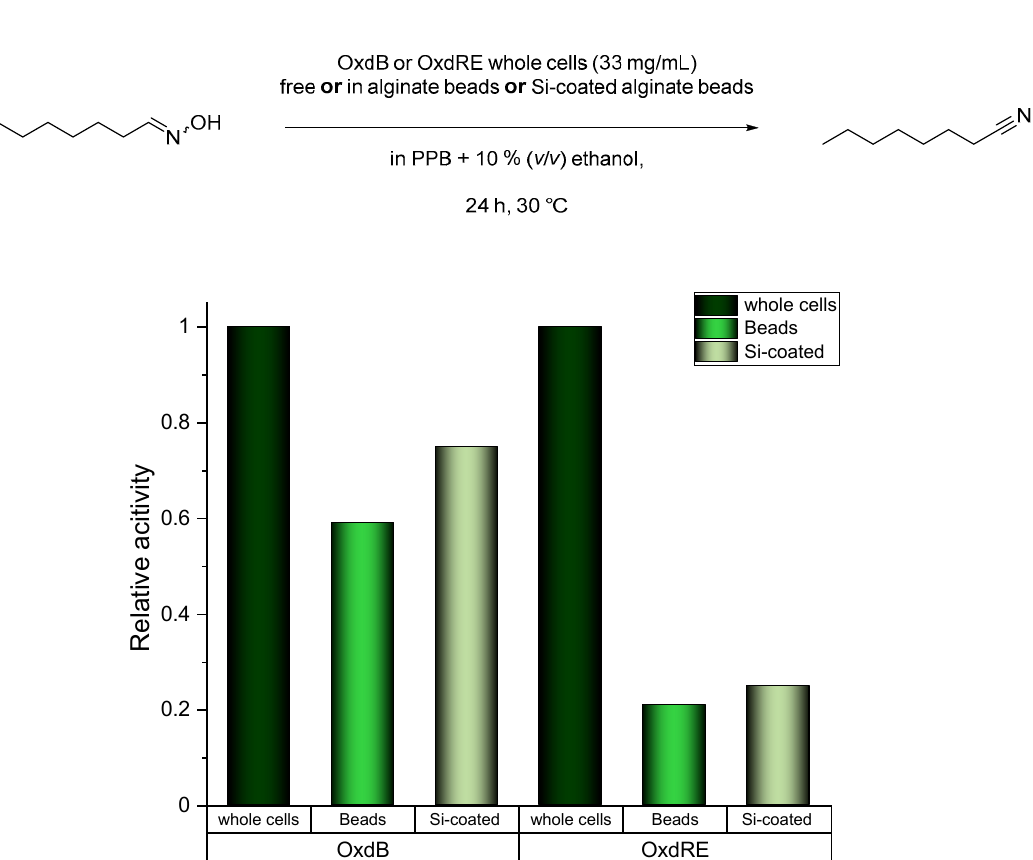
Figure 5. Comparison of OxdB and OxdRE whole cells and OxdB and OxdRE whole cells immobilized in alginate beads and immobilized in alginate beads coated with tetraethylorthosilicate (TEOS; Si-coated). Activities of OxdB and OxdRE free whole-cell catalyst were set as 100%.